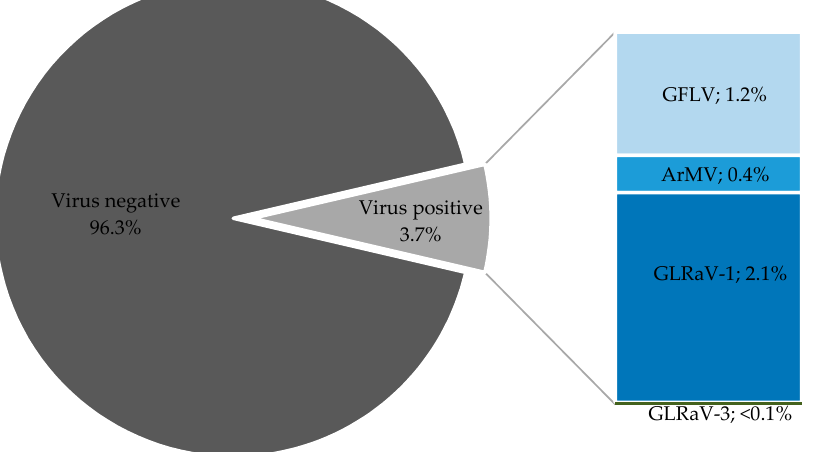
Figure 1. Only 3.7% of samples were found to be virus infected in 2009–2020. The left part of the chart shows the overall amounts of virus-negative (dark gray color) and virus-positive (light gray color) scion samples. The right chart represents the proportions of viruses found inside the 3.7% of virus-infected scion samples. Samples were tested for Grapevine fanleaf virus (GFLV); Arabis moasic virus (ArMV); Grapevine leafroll asscoiated virus 1 (GLRaV-1); Grapevine leafroll associated virus 3 (GLRaV-3). Mixed infections were not considered.